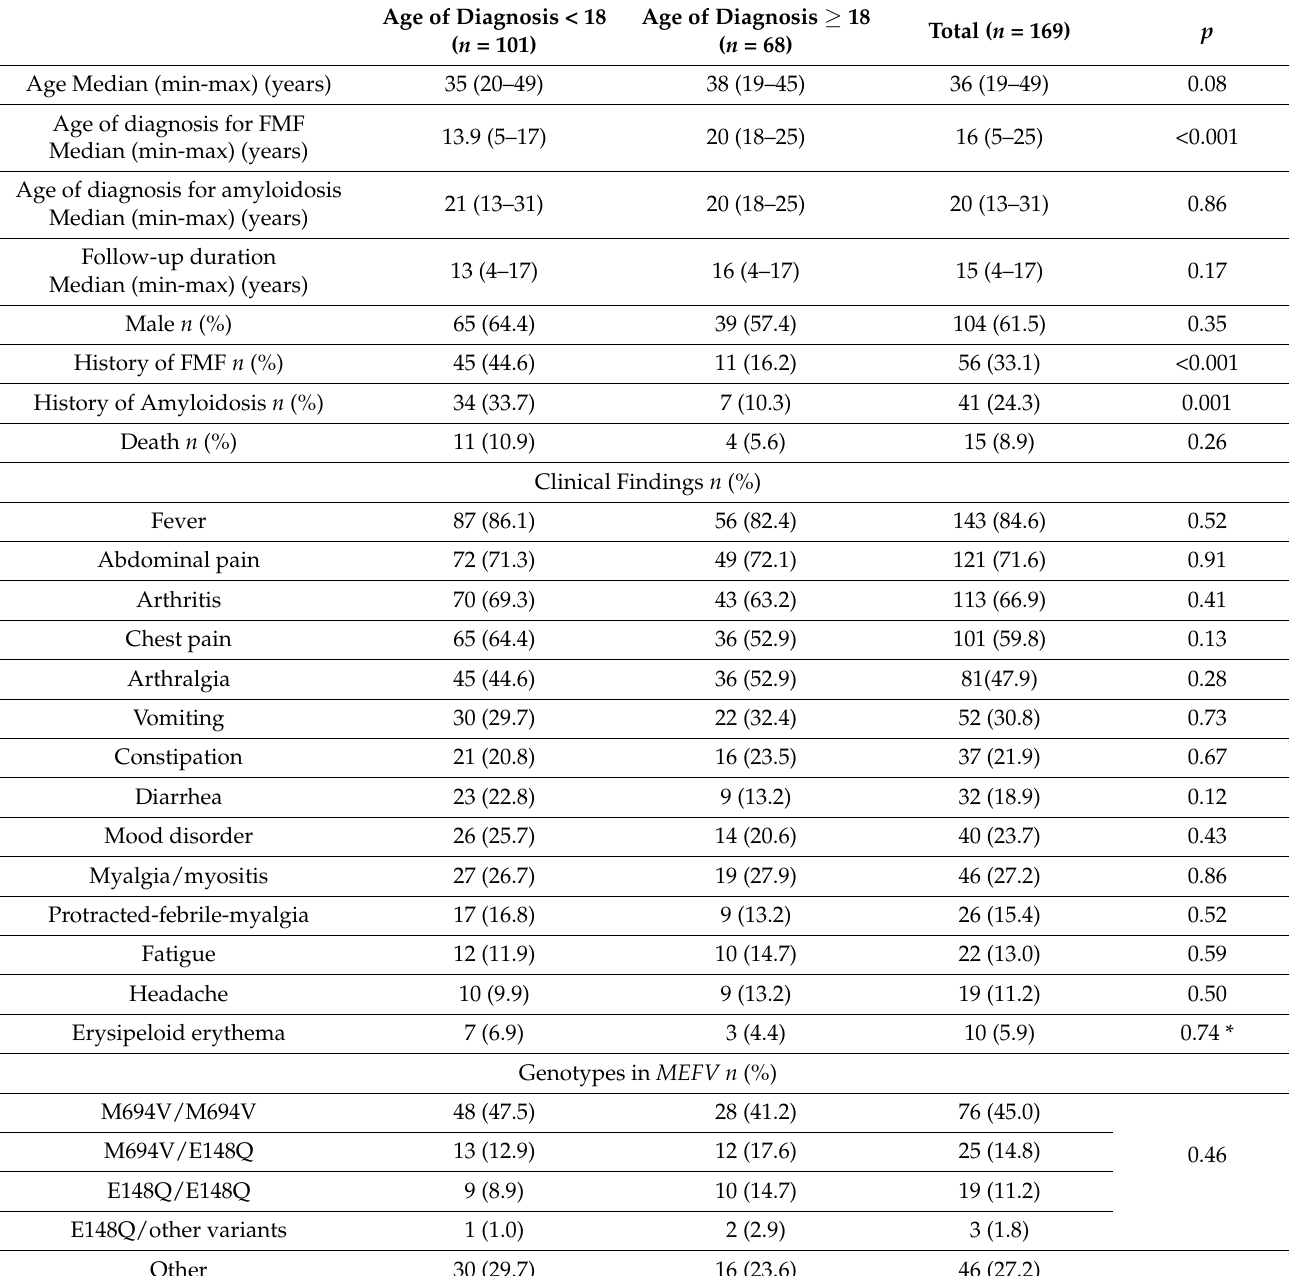
Table 1. Demographic characteristics and clinical findings, at the time of enrollment, in patients with familial Mediterranean fever (FMF)-related renal amyloidosis, and their comparison according to the age of diagnosis of